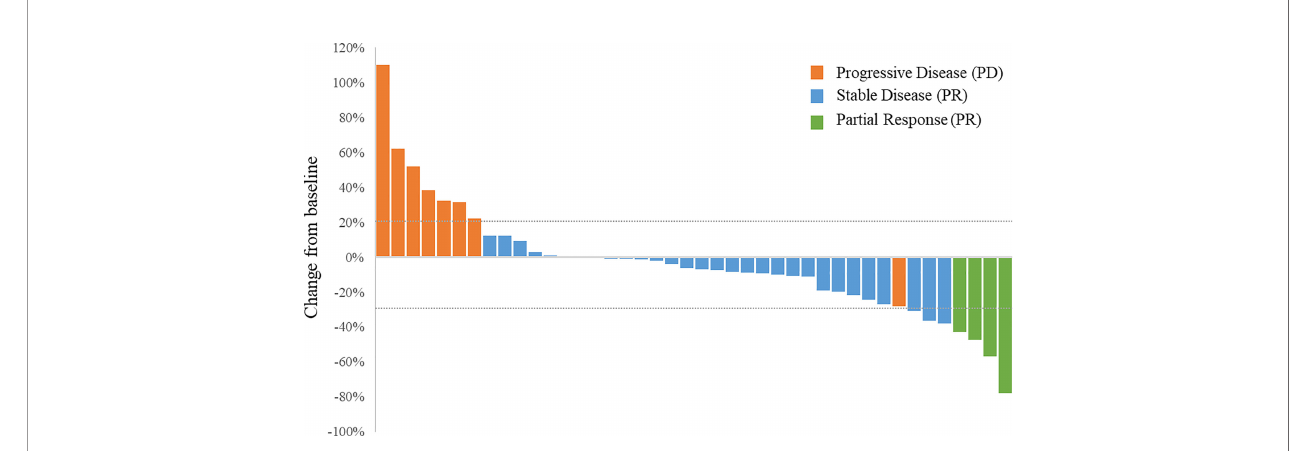
FIGURE 3 | Waterfall plot of the best percentage changes for the sum of target lesion diameters after anlotinib treatment are shown for individual patients with best objective response per RECIST version 1.1 as indicated by the color codes. CR, complete response; PD, progressive disease; PR, partial response; SD, stable